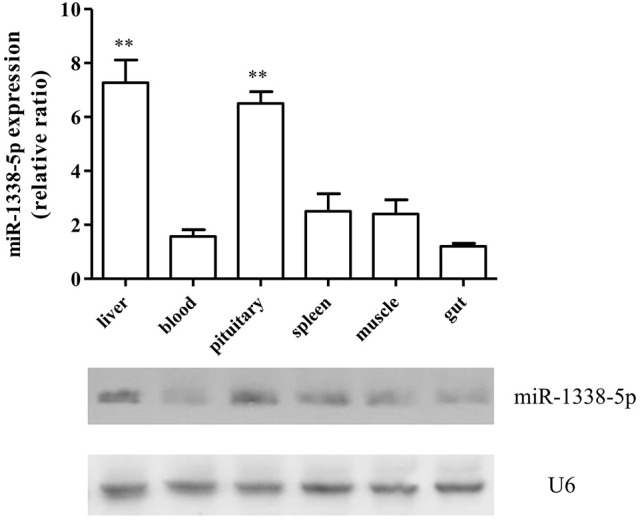
Expression pattern of miR-1338-5p in different GIFT tissues by qRT-PCR and northern blot (n = 8 replicates per group). Values are expressed as the relative ratio with U6 as an internal control. **P < 0.01, by Duncan's multiple range test. Fold changes in expression levels were normalized against the levels in gut tissues.